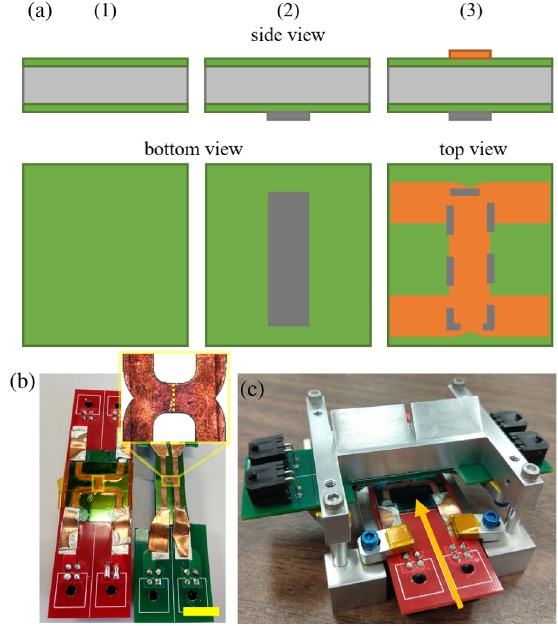
axis.FIG. 6. (a) Fabrication flow showing the side and top/bottom views of fabrication steps of (1) electrical insulation of silicon wafer (gray) using silicon nitride (green), (2) yoke electroplating (dark gray), and (3) copper electroplating (orange) on the opposite side, with the yoke extents shown by dashed lines. (b) MPQs mounted on PCBs. The yellow scale bar is 1 cm. The region of the quadrupole is shown by a yellow box for each half of the MPQ, and the inset is an optical microscope image of the right device ’ s active region. The dotted yellow line across the device has a length of 2 mm. (c) the fully assembled MPQ in the aluminum mount, with the beam propagation direction shown by the